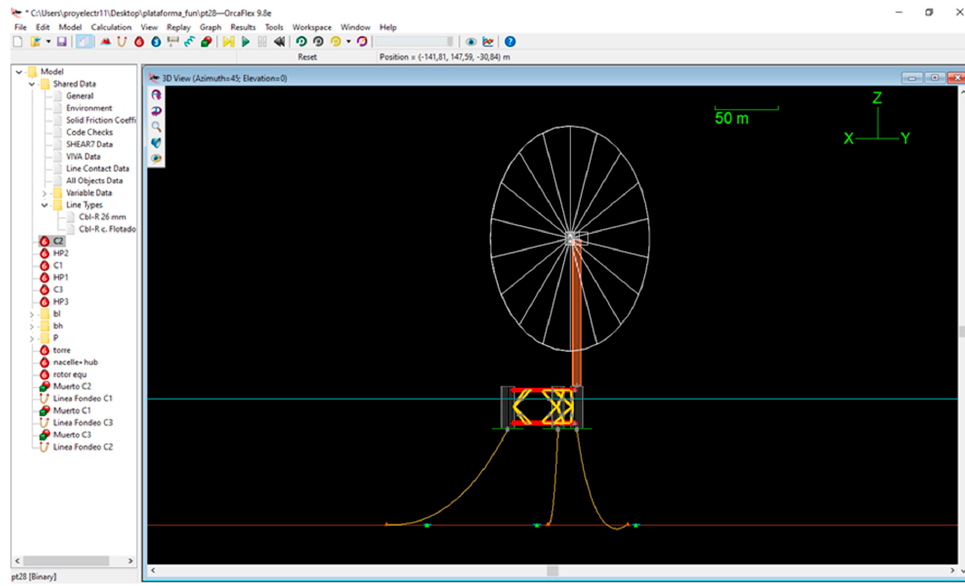
J. Mar. Sci. Eng. 2021 , 9 , x FOR PEER REVIEW Figure 9. Aspect of the modeling of the device in OrcaFlex. Figure 9. Aspect of the modeling of the device in OrcaFlex.